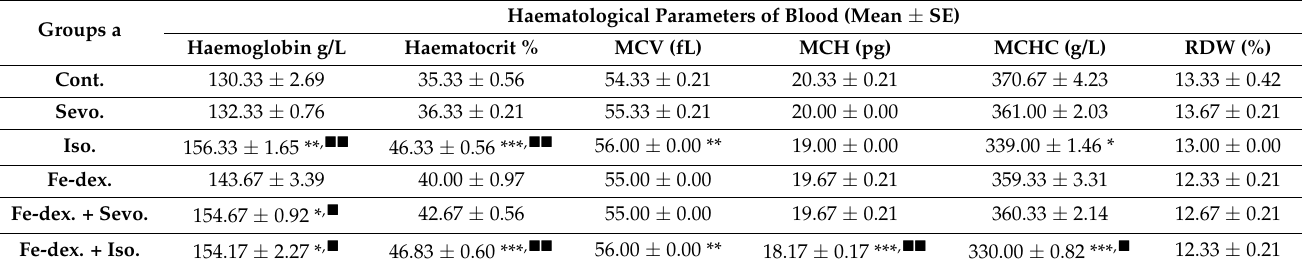
Table 3. Values of other haematological parameters in rats treated with inhalation anesthetics and iron dextran and their